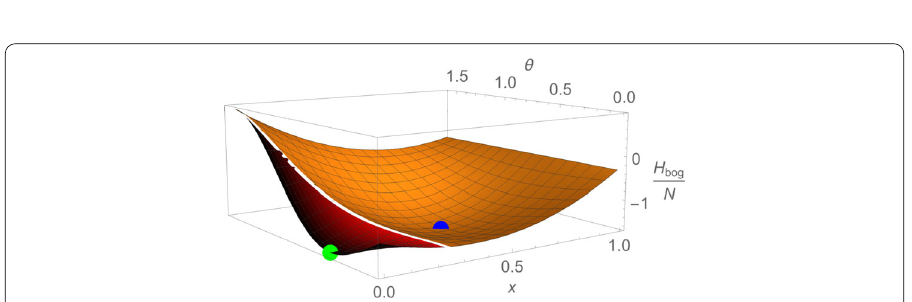
Figure 3 Bogoliubov energy (rescaled by the inverse particle number) for λ = 3.5 as a function of x and θ . The red surface is the region where (cid:3) 3 = π minimizes the energy and in the orange surface, (cid:3) 3 = 0 is